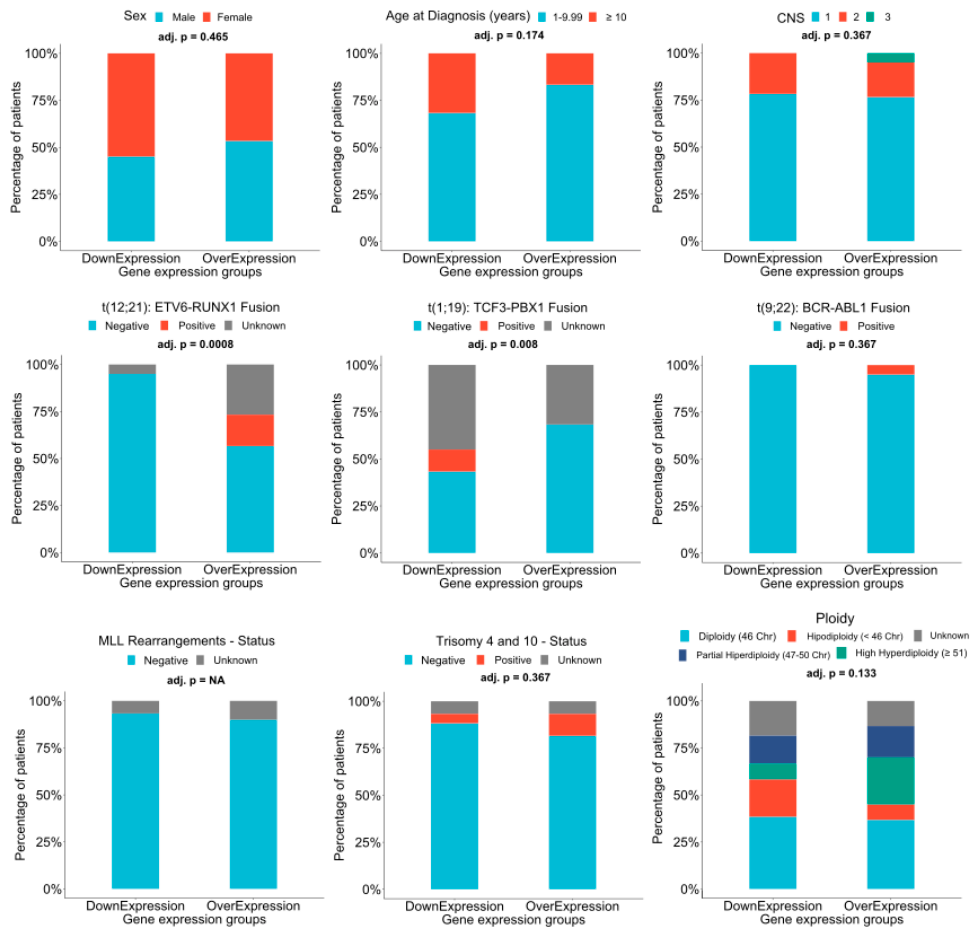
Figure A4. Comparison of clinical characteristics according to CCN2 expression in pediatric B-ALL patients from TARGET dataset. FDR-adjusted p-values of Fisher’s exact tests are shown. Abbreviations: Chr: Chromosome; CNS: central nervous system; CNS 1 means no CNS involvement, CNS 2 is a very low level, and CNS 3 is definite CNS involvement; NA: not available; MLL: MLL gene; t(12;21):